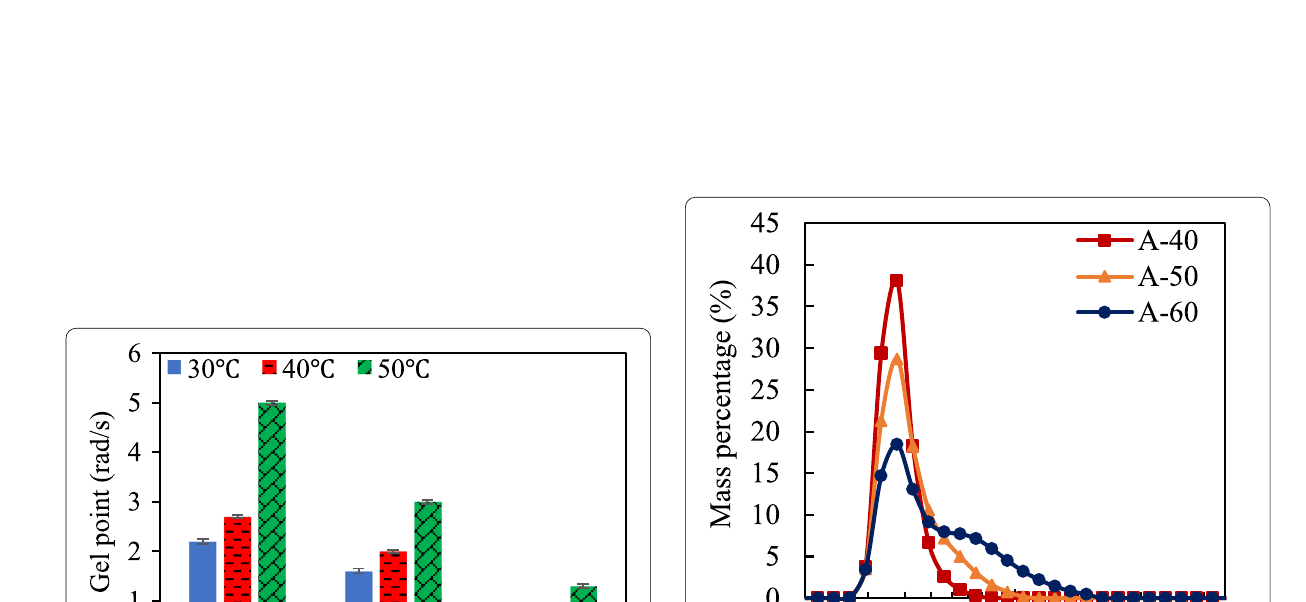
Fig. 11 Storage/loss modulus of asphalt emulsions